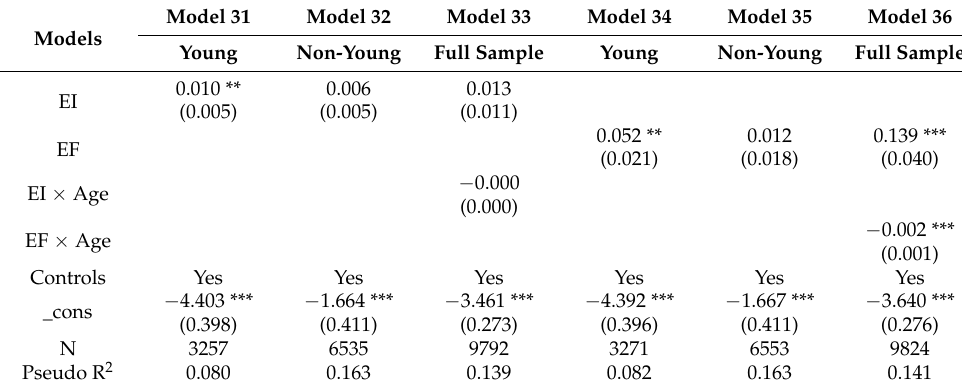
Table 7. Comparison of young/non-young